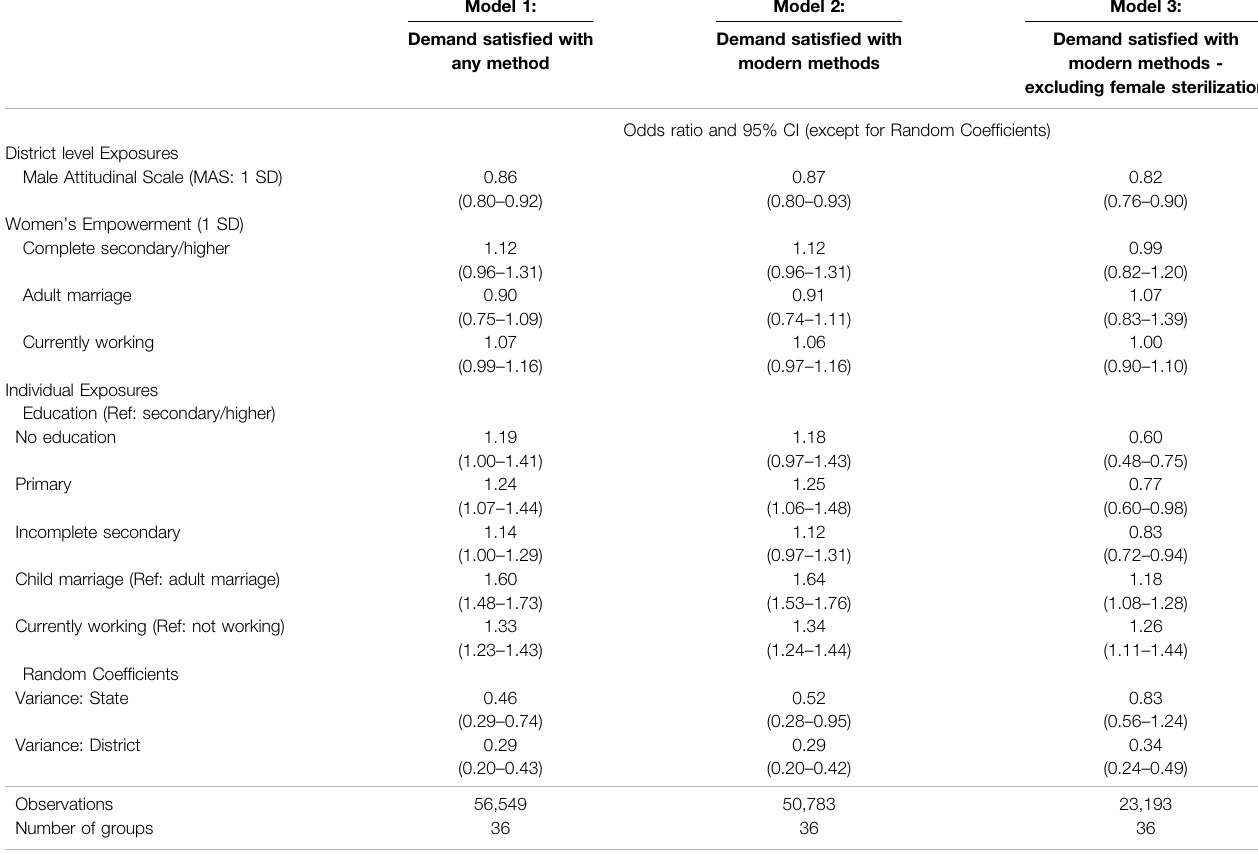
TABLE 3 | Multilevel associations of men ’ s attitudinal norms and demand satis fi ed for contraception, India NFHS-4. Model